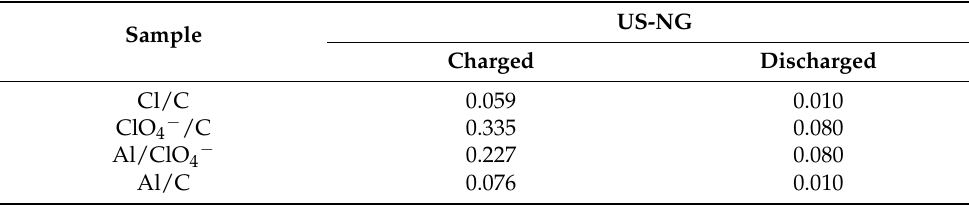
Table 2. Concentration ratios of ClO 4 − and Cl and Al and C for US-NG derived from XPS.